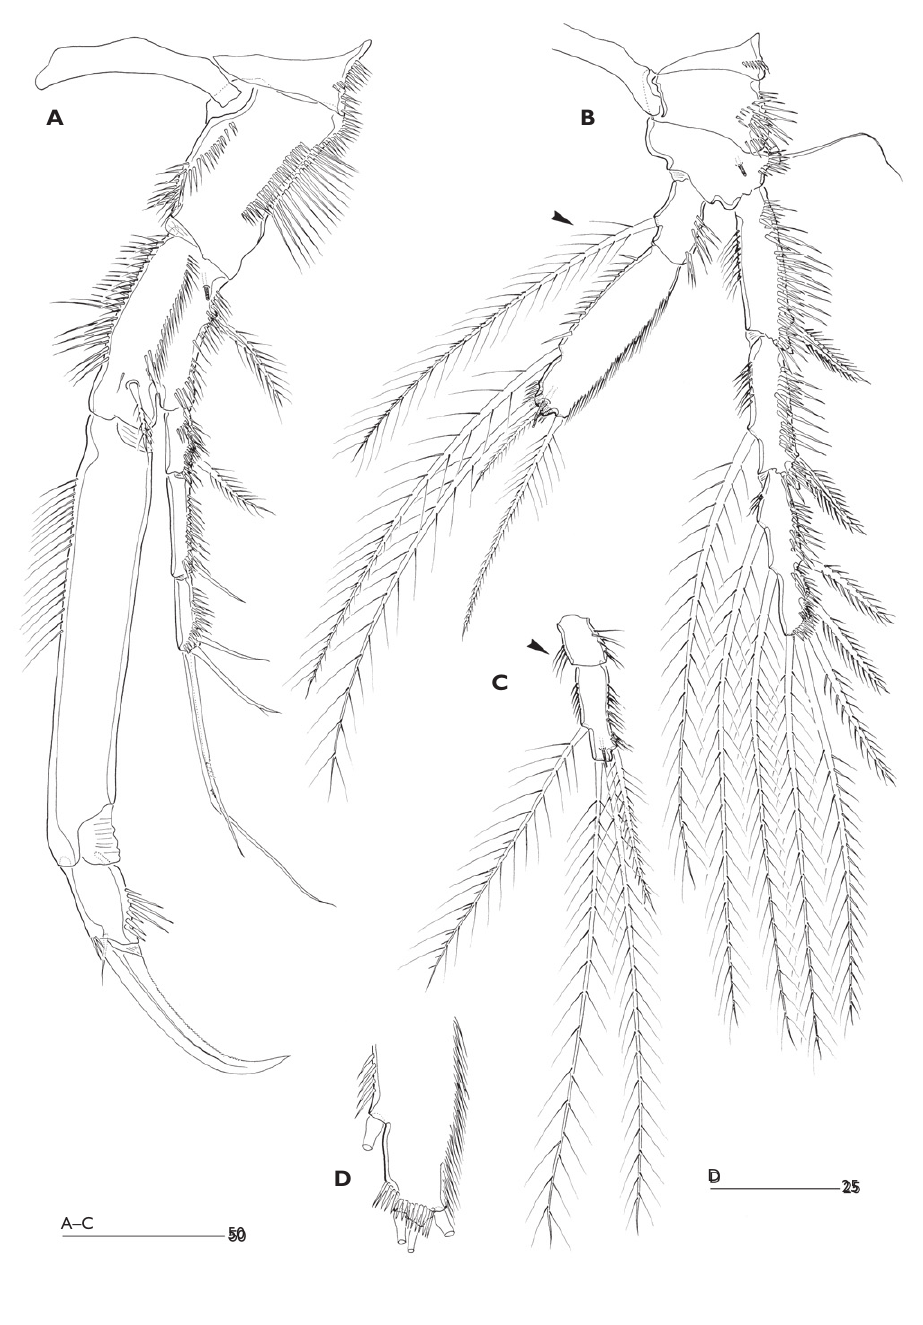
Figure 4. Marbefi a carthyi (Hamond, 1968), comb. n.: A P1 ♀ , anterior B P4 ♀ , anterior [inner seta on enp-1 arrowed] C P4 endopod ♂ , anterior [spinular rows on enp-1 arrowed] D distal part of P4 endopod ♀ ,